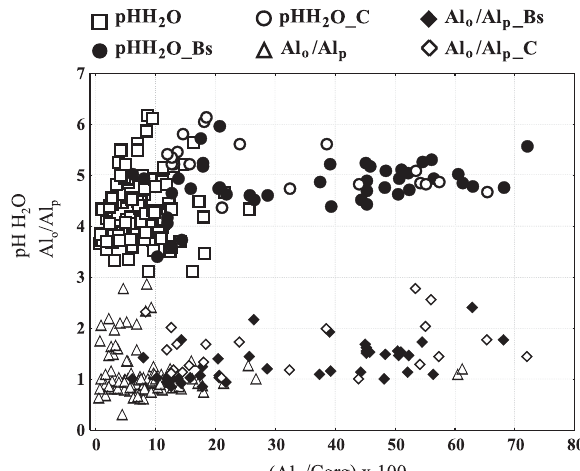
40.Figura 4. Relação entre (Al /C) x 100 e as seguintes p variáveis: pH extraído em água (pH H O) e a 2 relação Al /Al ; pHH O e Al /Al referem-se a todo o p 2 o p o conjunto de horizontes e perfis estudados, Figura 5. Correlação entre carbono orgânico (Corg) excetuando-se horizontes Bs, Bhs, Bsm e C; e alumínio extraído por pirofosfato (Al conjunto de amostras com relação (Al 100 superior a 20. Alp_20 e Alp_40 referem-se, respectivamente, às amostras com relação entre As linhas tracejadas indicam os valores de 1 e 5 20 e 40, e acima de para Al /Al e pH, o p